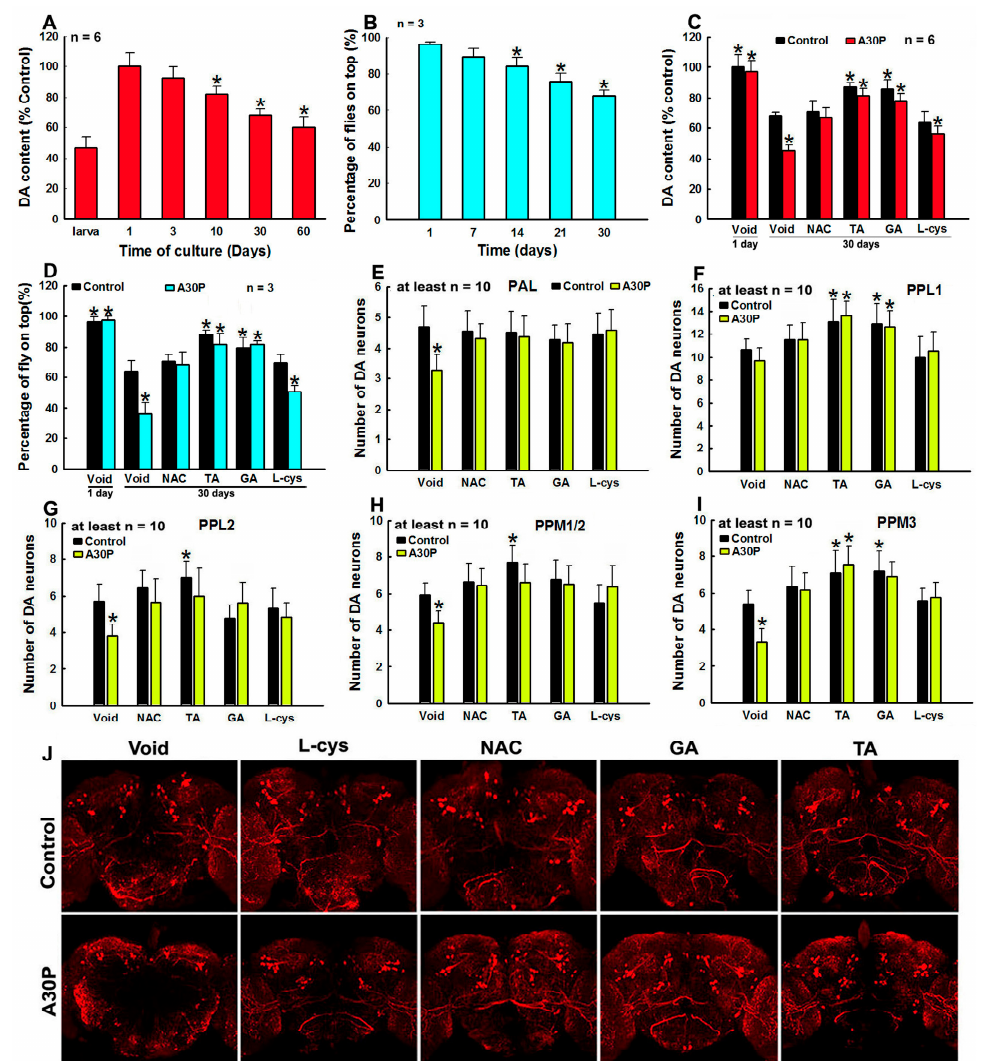
Figure 7. Protection against overexpression of mutant A30P α -synuclein ( α -syn) induced DA neuron degeneration in fly head by GA, TA, NAC, and L -cys. Yellow white control or transgenic α -syn A30P mutant flies were crossed with ddc-GAL4 lines to induce overexpression of A30P mutant α -syn specifically in DA neurons in transgenic fly heads. Flies were cultured for 30 days in the presence or absence of 2 mM GA, TA, NAC, and l -cys before check of fly climbing behavior and analysis of DA content and TH positive DA neuron numbers in fly heads. Flies without any drug treatments are set as void group. *, at least p < 0.05, compared with yellow white void flies without any drug treatment. ( A , B ), age dependent decrease of DA contents ( A ) and impairment of climbing capabilities ( B ) of yellow white files; ( C ) HPLC analysis of DA contents in transgenic fly heads; ( F ), monitoring climbing capabilities of transgenic flies. ( E – I ), numbers of TH positive DA neurons in di ff erent districts of transgenic fly heads. ( E ), PAL; ( F ), PPL1; ( G ), PPL2; ( H ), PPM1 / 2; ( I ), PPM3. ( J ) Confocal fluorescent images of TH positive DA neurons in transgenic fly heads with or without treatments by various agents.